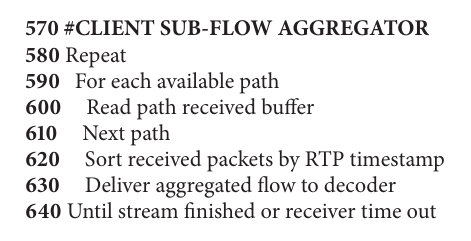
Algorithm 2: Client side aggregation of